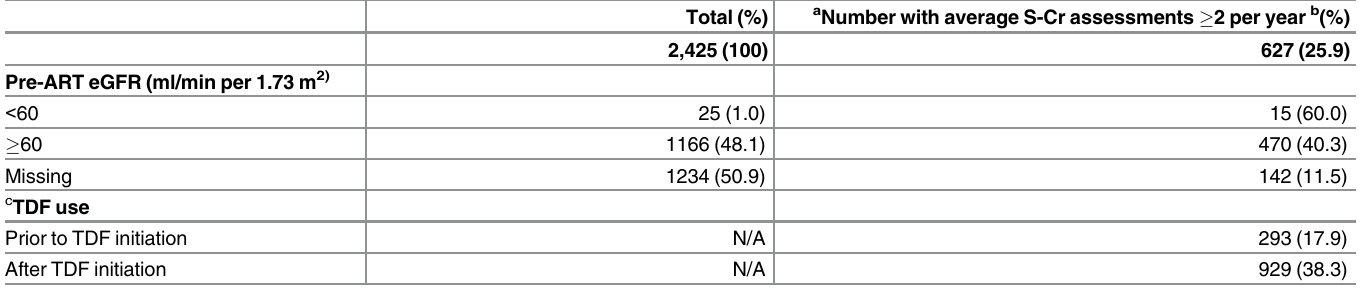
Note: a — Average calculated by the total number of serum creatinine assessments divided by the total follow-up time for each patient. b — Proportion of patients having two serum creatinine assessments divided by the total number of patients in the same category. c — Time-updated variable. The same patient can be counted in both